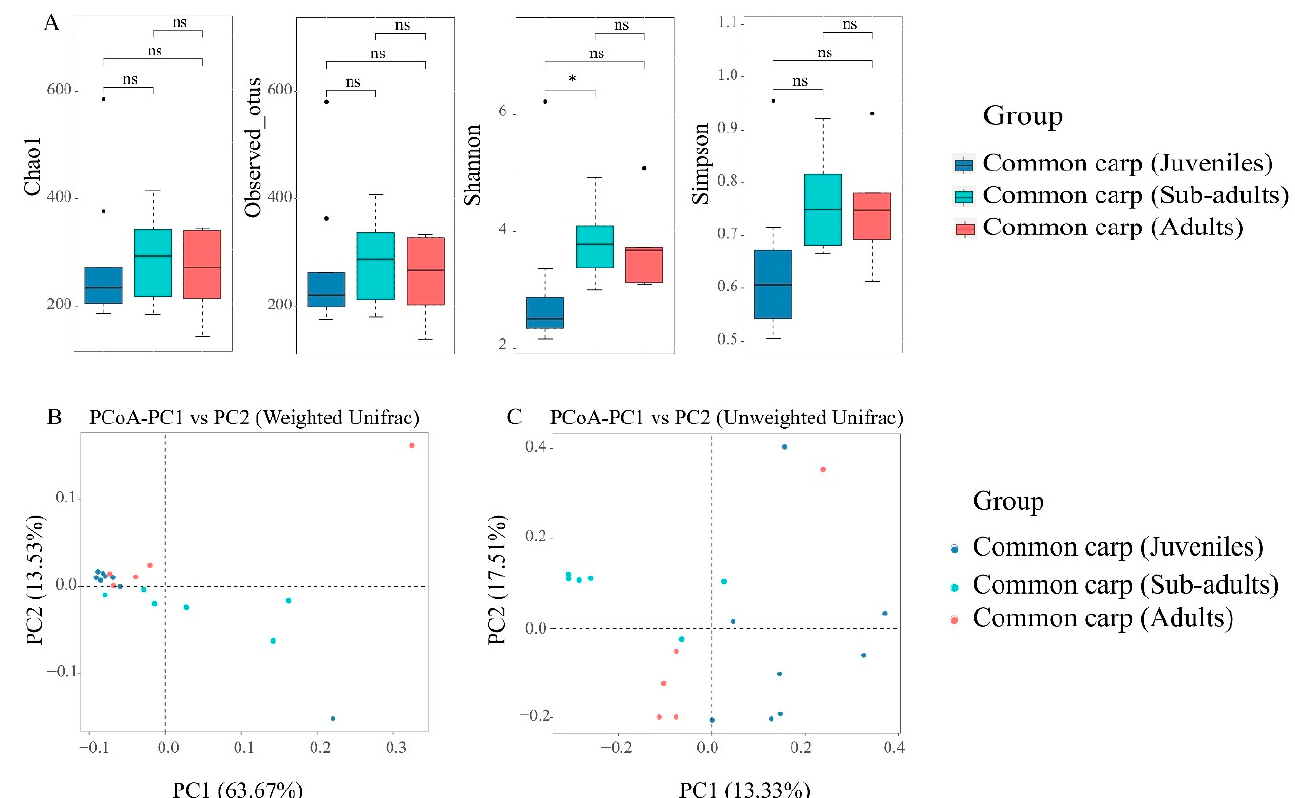
Figure 4. The alpha and beta diversity of gut microbial communities in common carp. ( A ) Box-and-whisker plots for comparison of alpha diversity of gut microbial communities in common carp between the three developmental stages. “*” indicates there are significant differences ( p < 0.05) between the groups and “ns” means no significant differences. ( B ) Two-dimensional principal coordi- nate analysis (PCoA) of gut microbial communities between the three host’s developmental stages based on weighted UniFrac ( B ) and unweighted UniFrac ( C ) distances. Each symbol corresponds to one sample. The first two principal coordinate (PC) axes are shown.